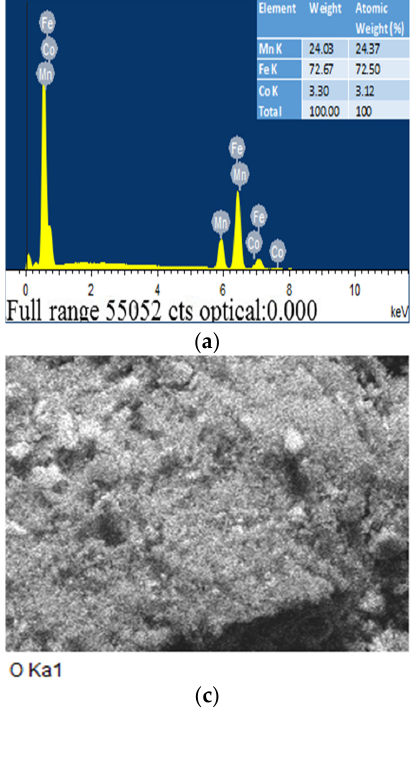
Figure 7. EDS analysis of reduced (Fe,Co,Mn)Ox: ( a ) EDS spectrum; ( b ) the treated and reduced spectrum, ( c ) electronic image of the (Fe,Co,Mn)Ox material; ( c ) EDS mapping picture of Fe, Mn, Co, and O; ( d ) EDS mapping of O; ( e ) EDS mapping of Mn; ( f ) EDS mapping of Fe; ( g ) EDS mapping of Co.